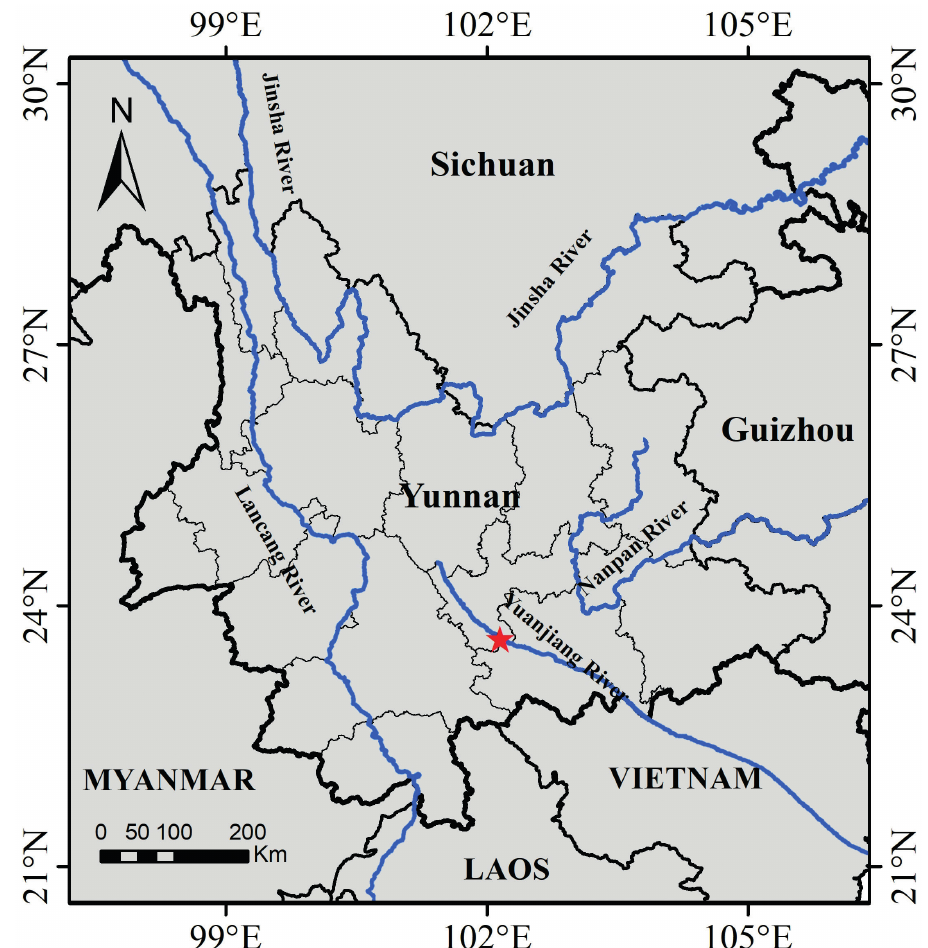
Figure 4. South-western China, showing the known distribution (red star) of Breynia hiemalis . The blue lines represent the